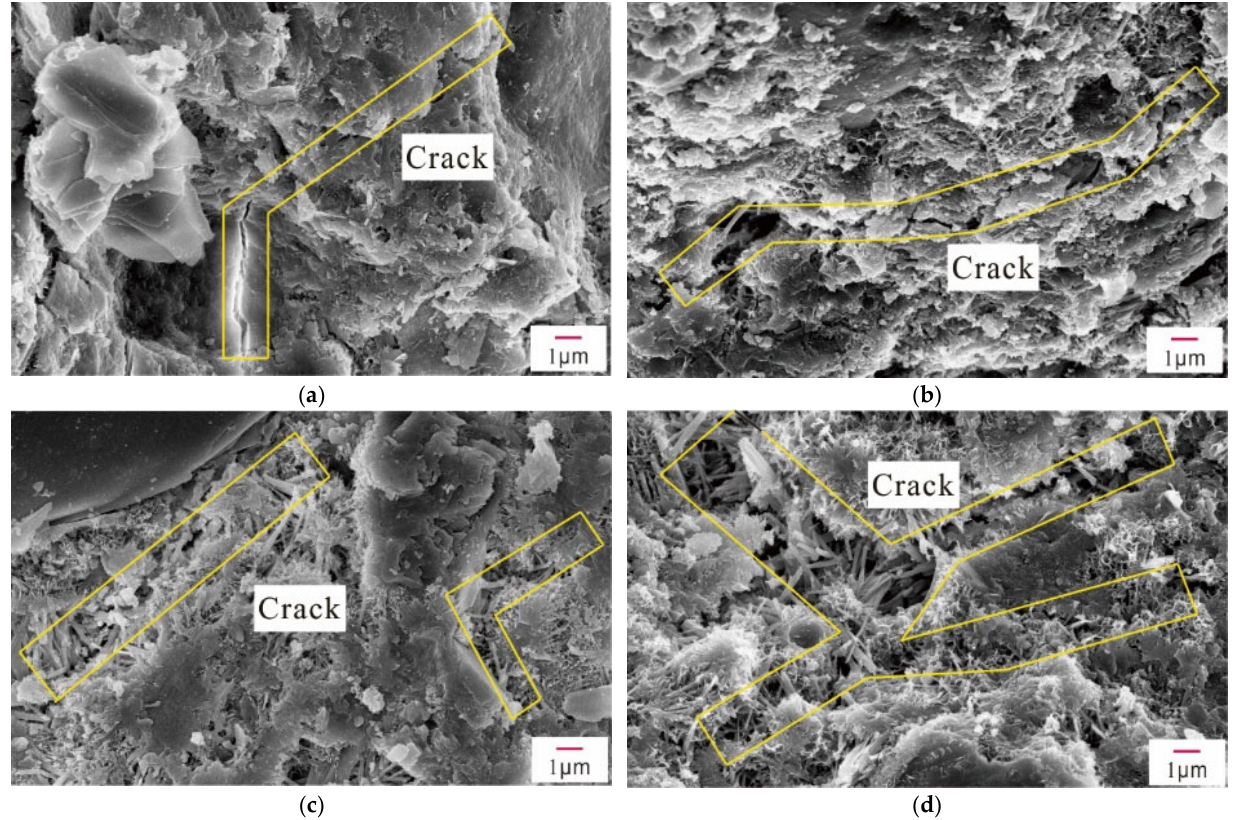
Figure 10. Crack evolution of concrete with different concentrations of Na 2 SO 4 ( a ) without sodium sulfate; ( b ) with 3% mixed sodium sulfate; ( c ) with 5% mixed sodium sulfate; ( d ) with 10% mixed sodium sulfate. These results showed that the corrosion products of Na 2 SO 4 changed the microstruc ‐ ture of the concrete, and furthermore, that C ‐ S ‐ H changed from a block to a honeycomb